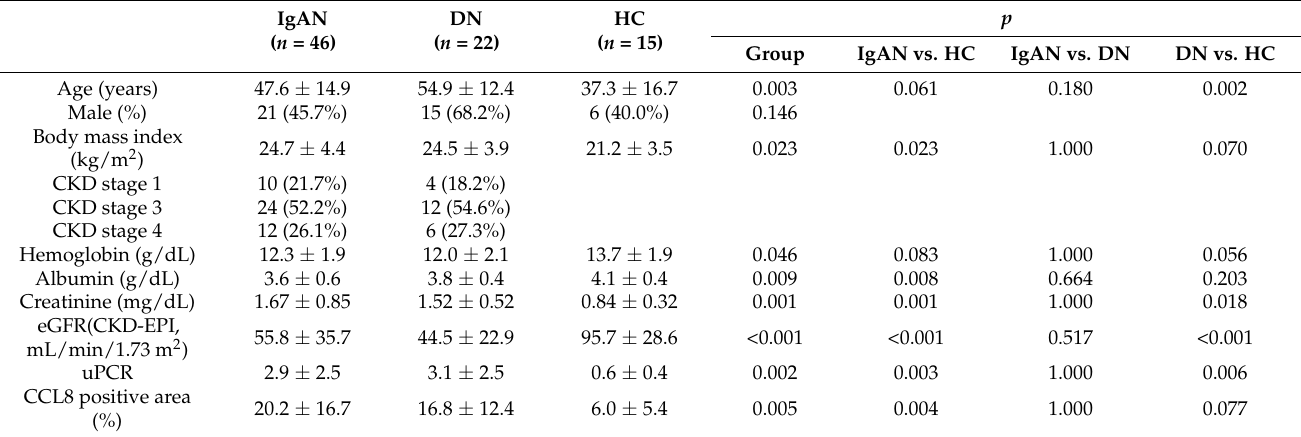
Table 2. Baseline characteristics of tissue CCL8 expression immunohistochemistry